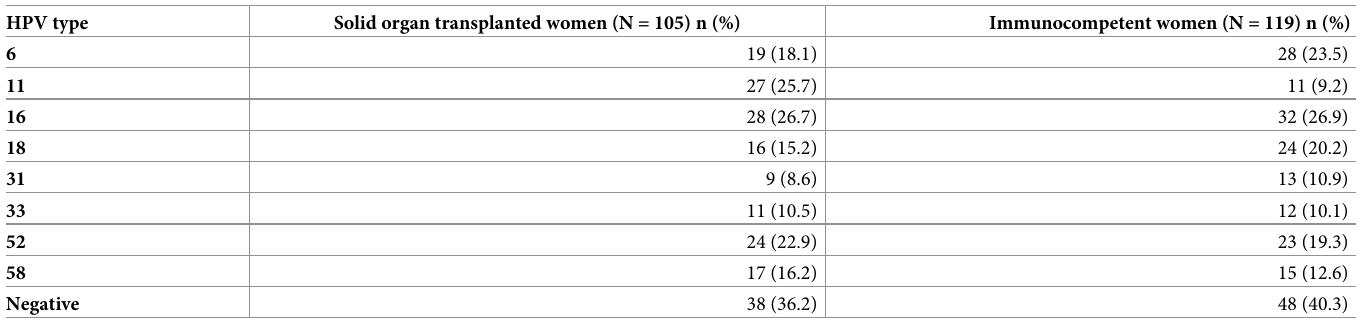
women (20.2%), but this difference was not statistically significant. But HR-HPV prevalence was significantly higher in SOT (19.4% vs 7.9%, p = 0.014). In addition, HPV serology demon- strated that most women (63.8% SOT and 59.7% immunocompetent) were seropositive for at least one HPV type, suggesting previous HPV exposure, despite absence of previous HPV related infection/diseases as reported by the participants. We also found a 5-fold greater preva- lence of LSIL and HSIL in SOT compared to immunocompetent women of the same age range (15% vs. 2.4%). These results suggest similar exposure / HPV infection in both group, with higher HPV persistent infection in SOT women, resulting in higher frequency of HPV-related precursor lesions. Table 3. HPV seroprevalence distribution, according to HPV genotype and study population. HPV type